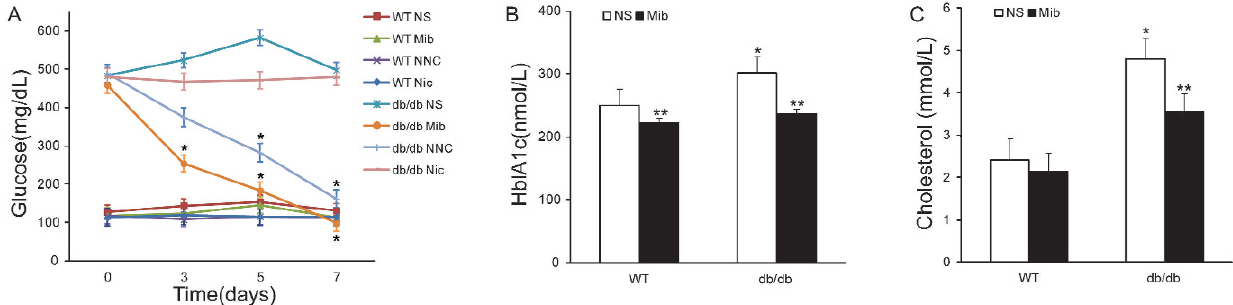
Figure 2 - The hypoglycemic and hypolipidemic effects of Ca 2 + channel antagonists in db / db mice. A) Time-dependent changes in blood glucose concentration during drug treatment. B) Serum HbA1c in mice with and without mibefradil injection. C) Serum total cholesterol in mice with and without mibefradil injection. Abbreviations: WT, nondiabetic wild-type mice; db / db , db / db mice; NS, normal saline; Mib, mibefradil; NNC, NNC 55-0396; Nic, nicardipine. * p , 0.05, n=6, compared with WT NS group; ** p , 0.05, n=6, compared with NS group of the same type of mice at the same time. Statistical analyses were performed with Student’s t-test (A) or ANOVA (B and C) according to the specific